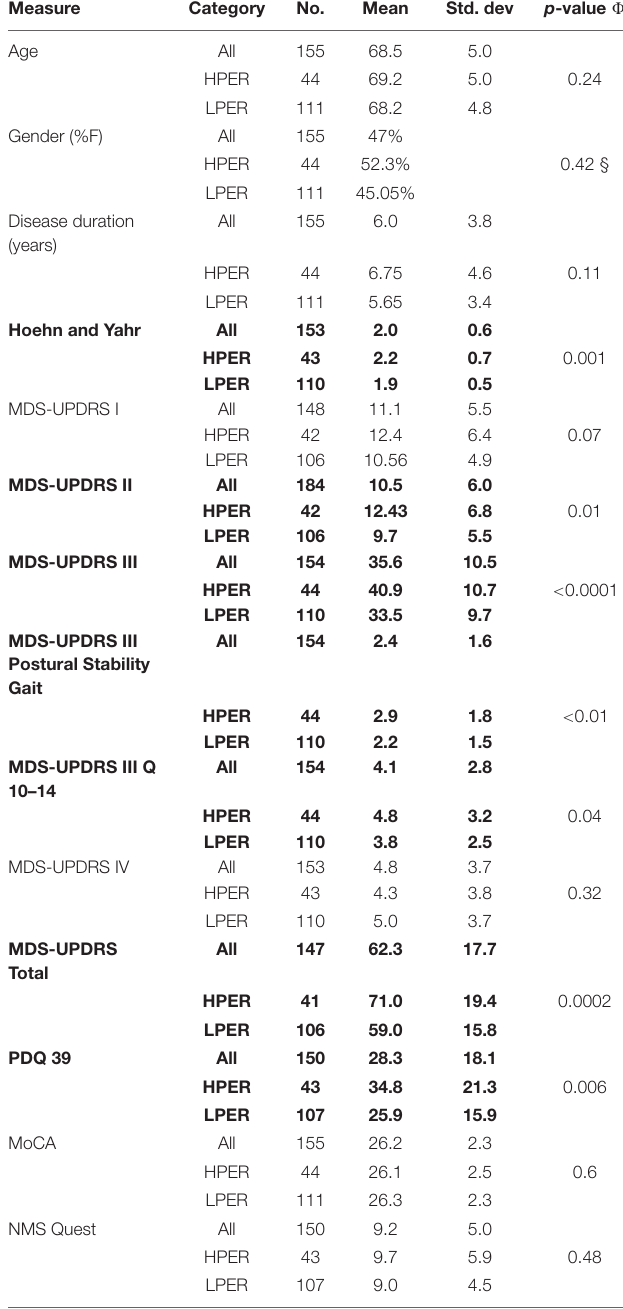
TABLE 4 | Demographics for Cohort